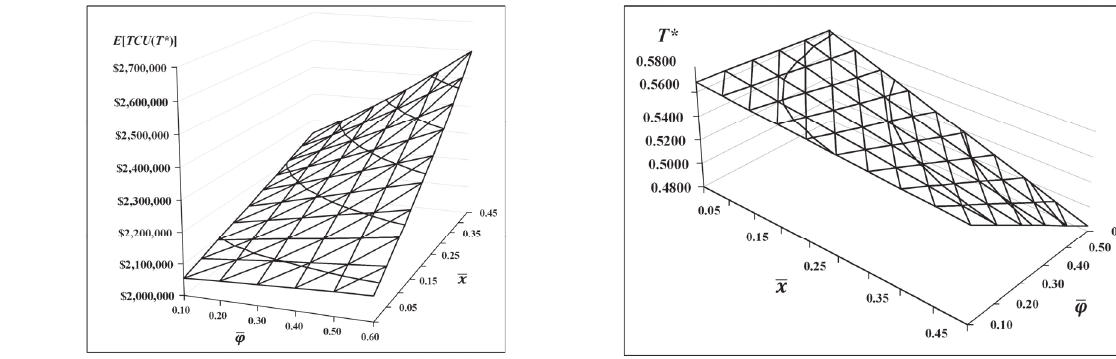
Fig. 12. The behavior of optimal T * regarding the collective impact from and and x